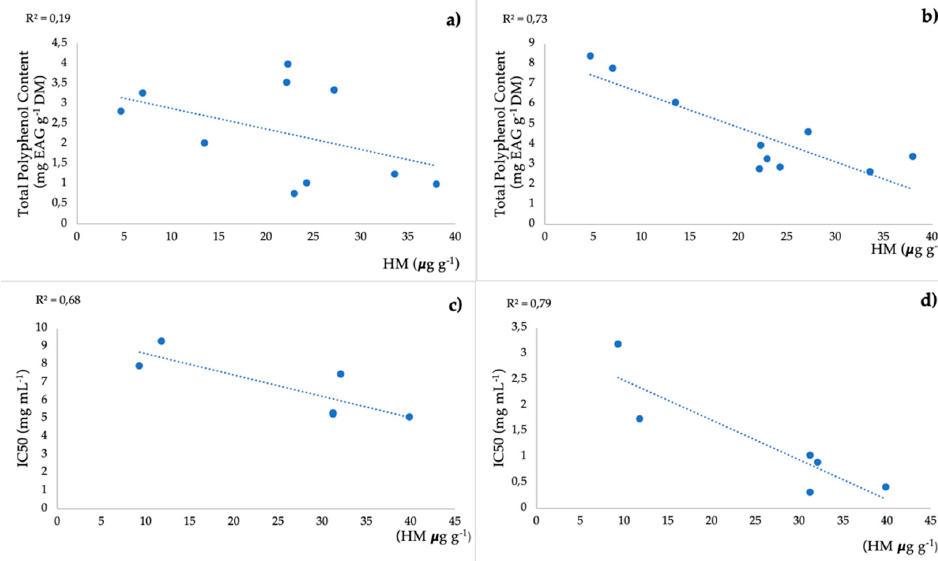
Figure 3. Correlation between total HMs concentrations and total polyphenol content in extracts of F. circummediterranea ( a ) and T. pratense ( b ), and total HMs concentrations and antioxidant activities of F. circummediterranea ( c ) and T. pratense ( d